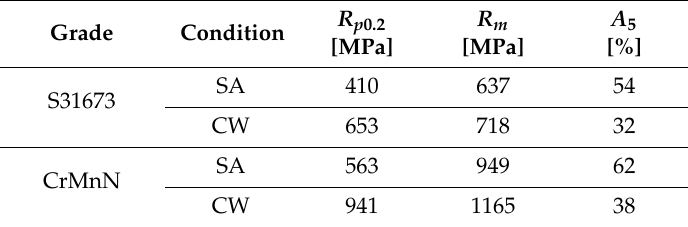
Table 2. Mechanical properties of tested grades in solution annealed (SA) and cold worked (CW) condition at room